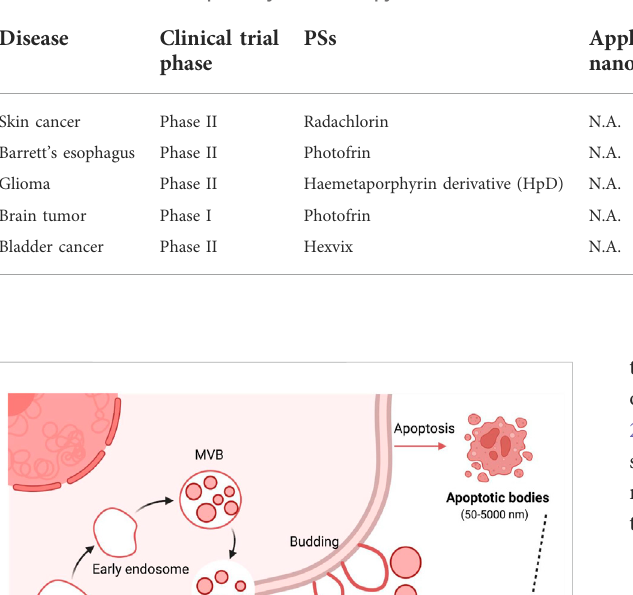
TABLE 2 Clinical trials of photodynamic therapy on cancers.